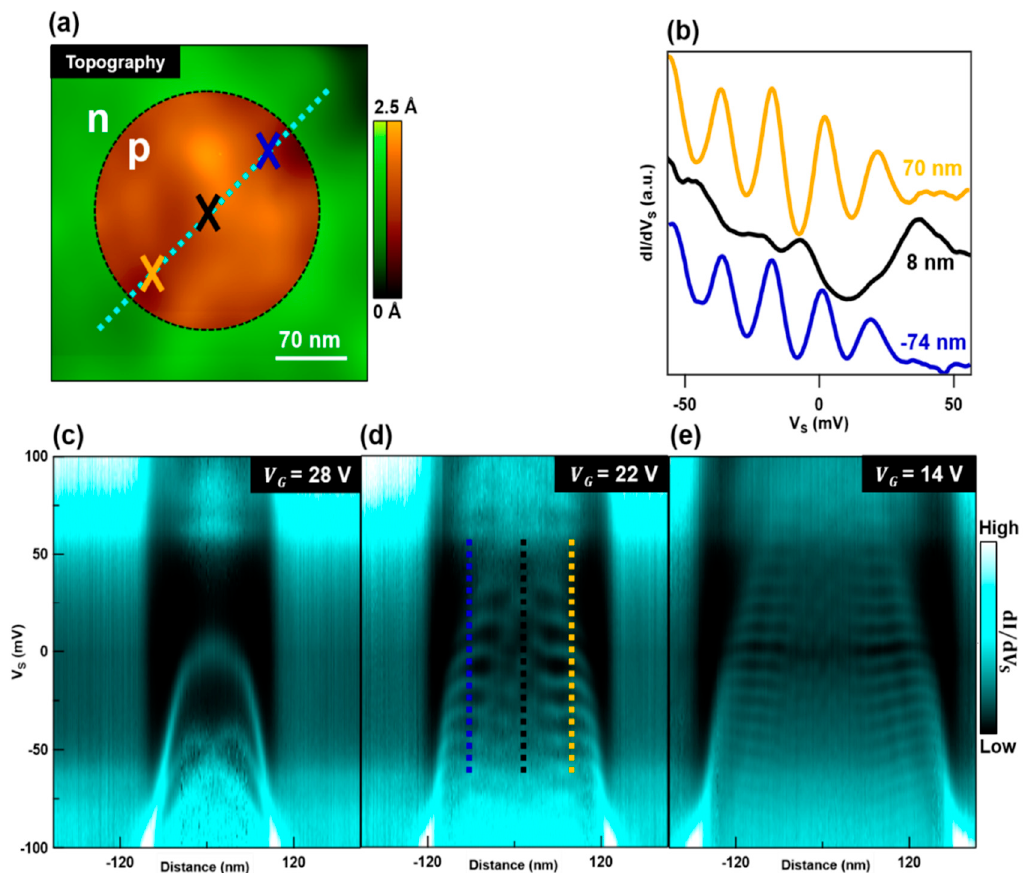
Figure 2. Scanning Tunneling Spectroscopy (STS) of an exposed graphene QD. ( a ) Topography of graphene acquired with the scanning tunneling microscope. Regions where graphene is n and p -doped are indicated with green and brown color scales, respectively. ( b ) Di ff erential conductance spectra ( dI / dV S ) obtained at the corresponding crosses indicated in ( a ). Each spectrum is o ff set for clarity and was taken with V G = 22 V. ( c – e ) Spatial dependence of dI / dV S spectra with di ff erent V G , which is indicated in each panel. These images map the spatial dependence of graphene QD states obtained along the dashed cyan line in ( a ). Dashed vertical lines in ( d ) correspond to spectra displayed in ( b ). Tunneling parameters: V S = − 0.1 V, I = 1 nA, V ac = 2 mV.